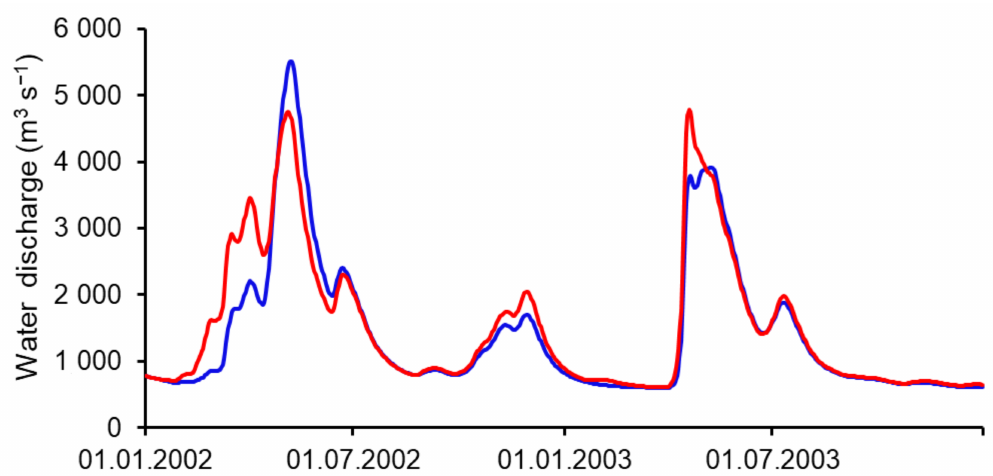
Figure 13. Simulated hydrographs of lateral inflow into the NKR under historical (blue) and DC scenarios (red) over the 2002–2003 period.